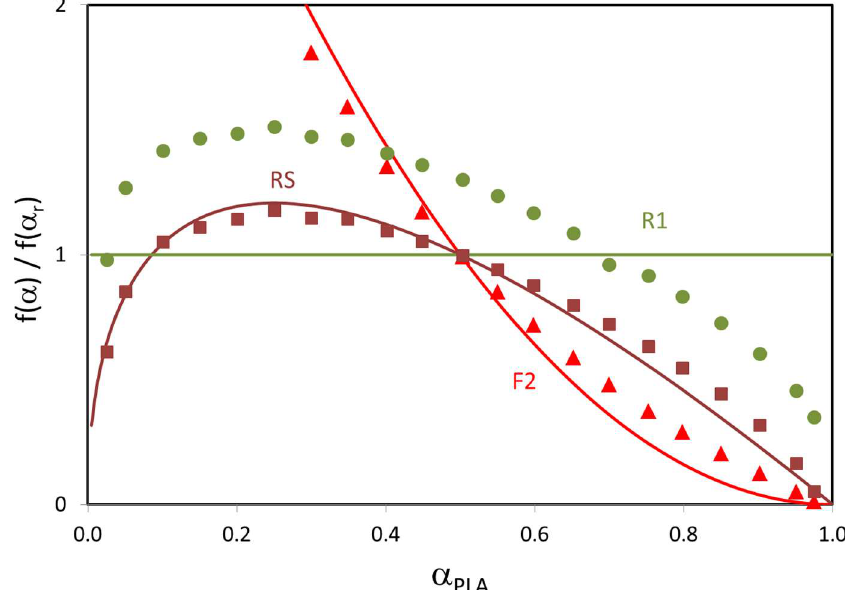
Figure 5. Variation of standardized conversion functions with PLA conversion for bioblend containing 90% of PLA non-treated by reactive extrusion (PLA/PA 90/10) when three reaction mechanisms were considered). Symbols are experimental values and lines are theoretical values.